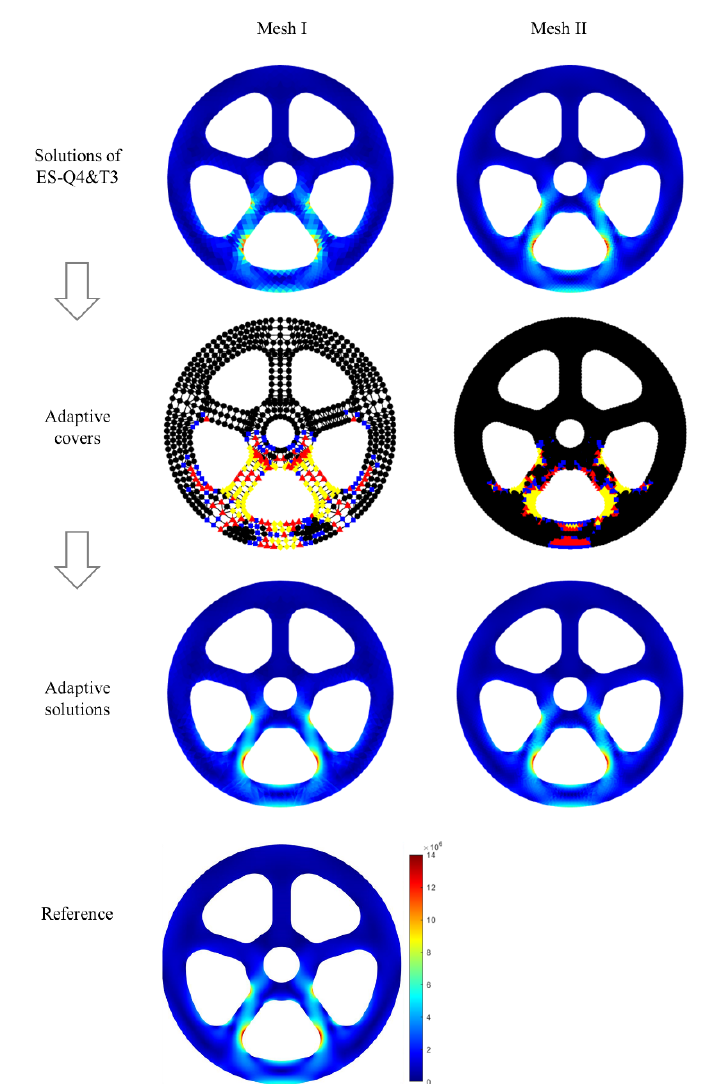
Figure 12. von Mises ( τ ) predictions obtained by the edge-based smoothed elements (ES-Q4, ES-T3) and the proposed adaptive enrichment scheme for the wheel problem shown in Figure 11.